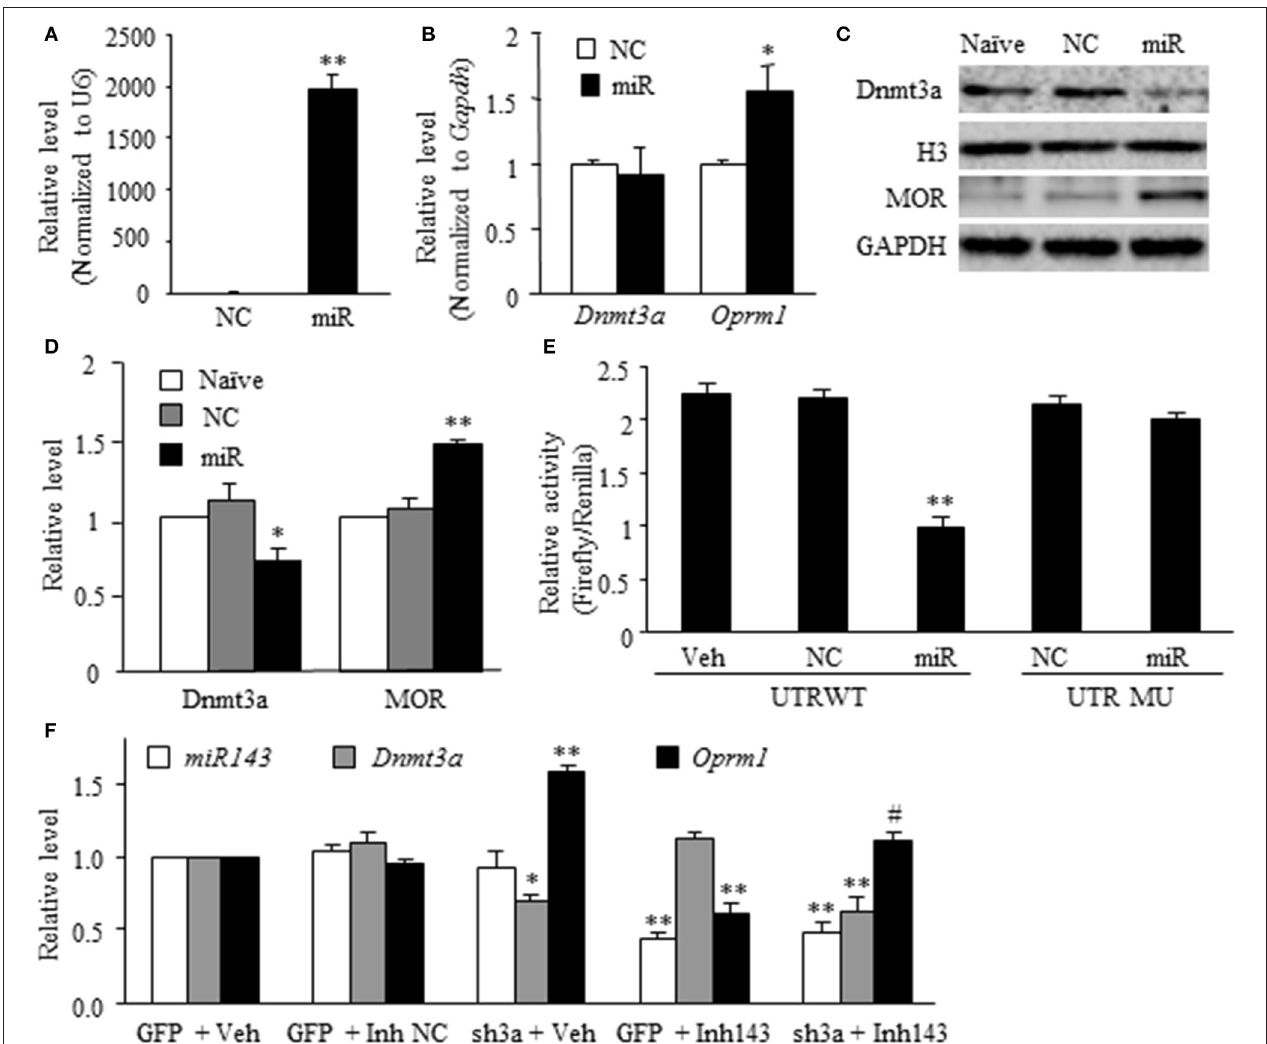
FIGURE 3 | miR-143 directly regulates the expression of Dnmt3a and its downstream Oprm1 mRNA and MOR in DRG neurons. miR, microRNA; NC, negative control; Veh, vehicle; (A,B) Transfection of miR-143 mimics (but not negative control) increased the expression of miR-143 (A) and Oprm1 mRNA (B) and had no effect on the expression of Dnmt3a mRNA in the cultured DRG neurons. n = 3 repeats/group. Two-tailed, unpaired Student’s t- test. * P < 0.05 or ** P < 0.01 vs. the corresponding negative control group. (C,D) Transfection of miR-143 mimics (but not negative control) decreased the expression of Dnmt3a and increased the expression of Oprm1 mRNA and MOR in the cultured DRG neurons. (C) representative Western blots. (D) Statistical summary of the densitometric analysis. n = 3 repeats/group. One-way ANOVA followed by Tukey post-hoc test. * P < 0.05 or ** P < 0.01 vs. the corresponding naive group. (E) Luciferase reporter assay revealed that transfection of miR-143 mimics, but not negative control, decreased translational activity in the 3 ′ untranslated region (UTR) of Dnmt3a mRNA containing the miR-143 binding sites (UTR WT) and failed to affect basal luciferase activity in the mutant 3 ′ -UTR of Dnmt3a mRNA in which the miR-143 binding sites was mutated (UTR MU). n = 3 repeats/group. One-way ANOVA followed by Tukey post-hoc test. ** P < 0.01 vs. the corresponding vehicle group. (F) Transfection of miR-143 inhibitors (Inh143), but not inhibitor negative control (Inh NC), reduced the expression of miR-143 and Oprm1 mRNA and had no effect on the expression of Dnmt3a mRNA in the cultured DRG neurons. The miR-143 inhibitors-induced reduction in Oprm1 mRNA was completely reversed by co-administration of AAV5 expressing Dnmt3a shRNA (sh3a). n = 3 repeats/group. One-way ANOVA followed by Tukey post-hoc test. * P < 0.05 or ** P < 0.01 vs. the corresponding GFP (enhanced green fluorescent protein) plus vehicle group. # P < 0.05 vs. the corresponding GFP plus Inh143